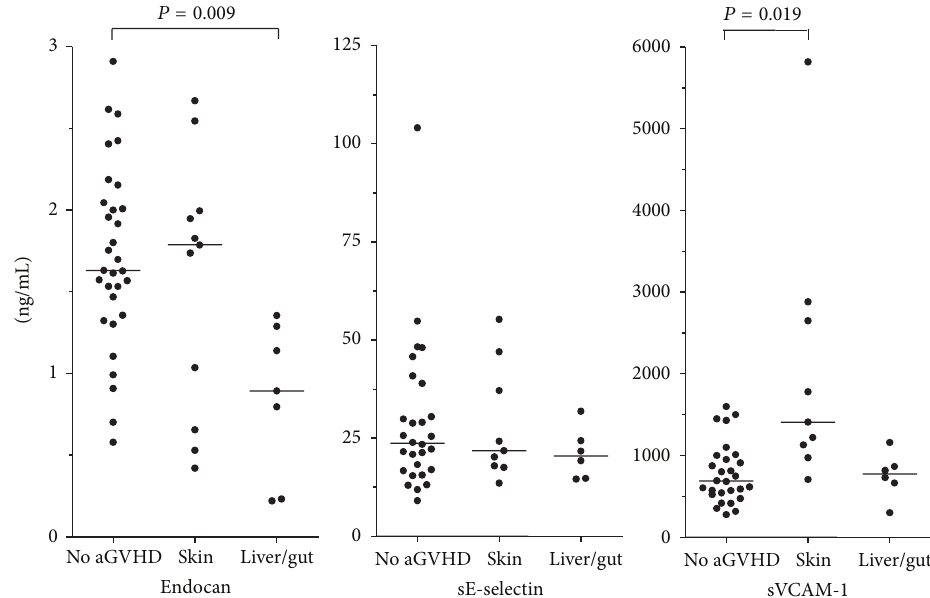
Figure 4: Differences in the serum profile of soluble adhesion molecules derived from endothelial cells (endocan, E-selectin, and VCAM-1) are associated with posttransplant acute GVHD. Serum levels of endothelium-derived soluble adhesion molecules were compared for patients without acute GVHD, patients with skin GVHD alone, and patients with liver and/or gastrointestinal affection during acute GVHD. Serum levels of endocan were available for all 56 patients (11 with acute GVHD in the skin and 7 with liver/gut involvement); for VCAM-1 and E-selectin serum levels were available only for 50 consecutive/unselected patients (9 with acute GVHD in the skin only and 6 with liver/gut involvement). The statistically significant differences (Mann-Whitney 𝑈 test) are indicated in the